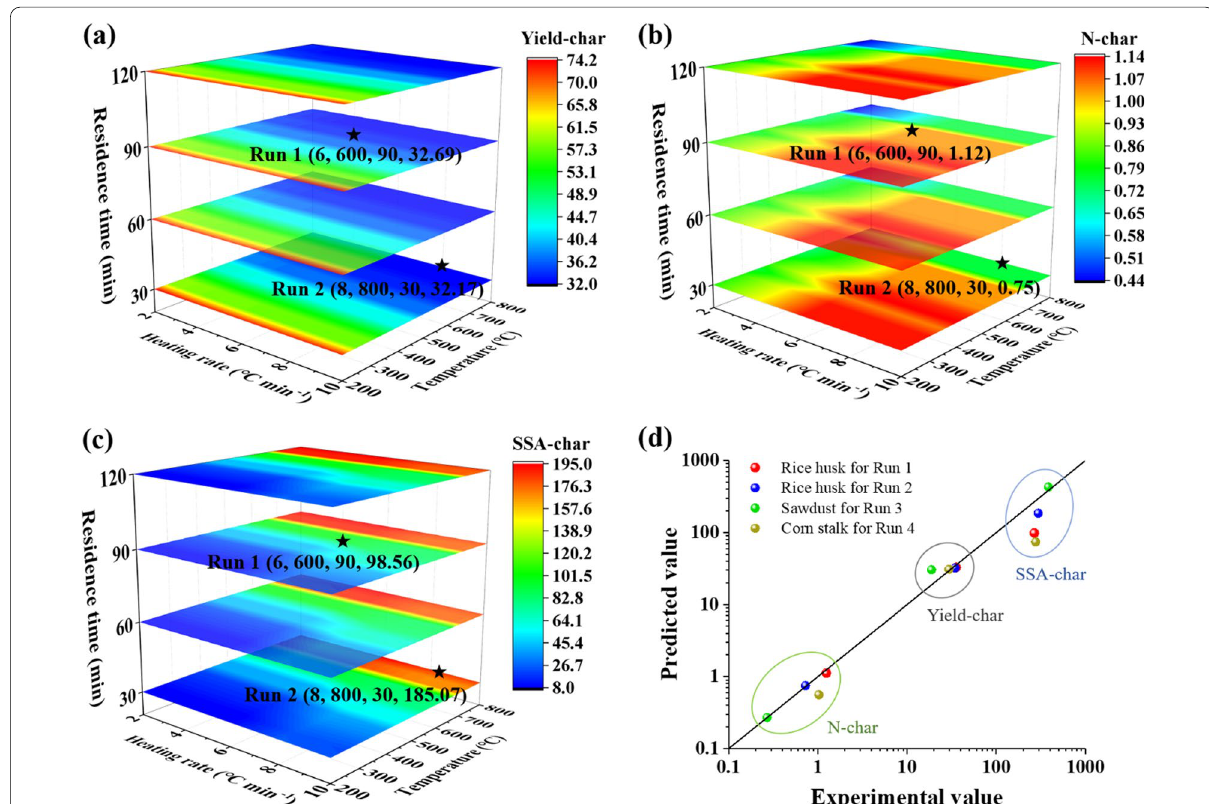
Fig. 7 The optimal schemes of three target parameters derived from a – c rice husk and d the experimental verification of four optimal